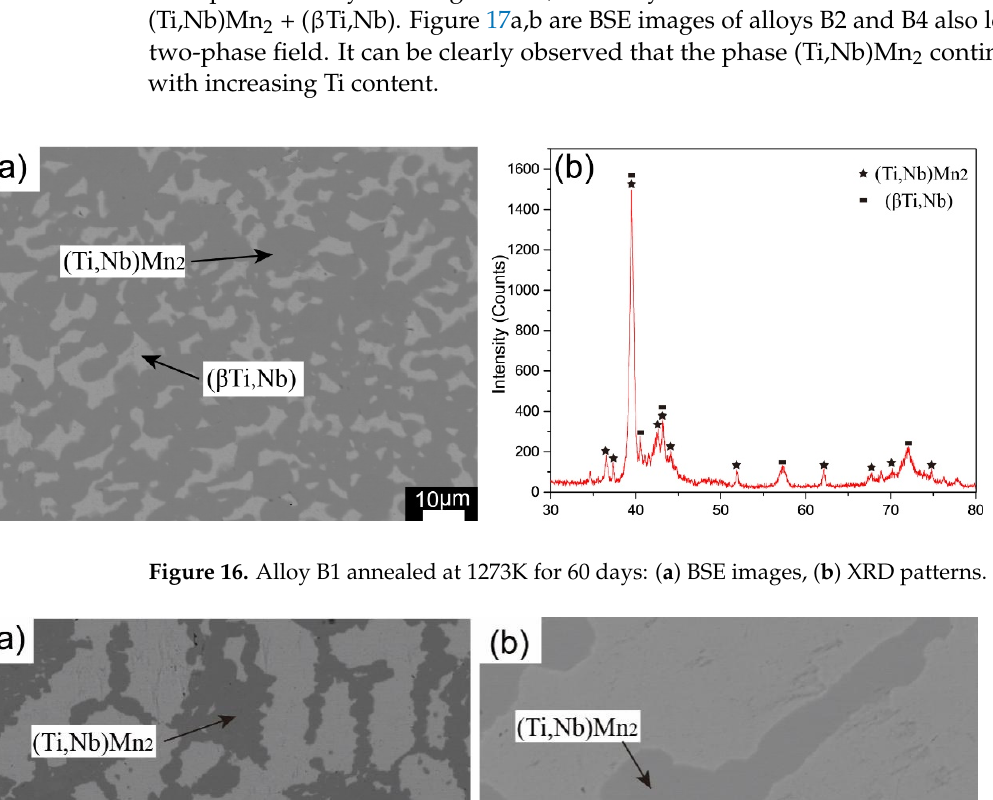
Figure 15. Alloy B9 annealed at 1273K for 60 days: ( a ) BSE images, ( b ) XRD patterns.